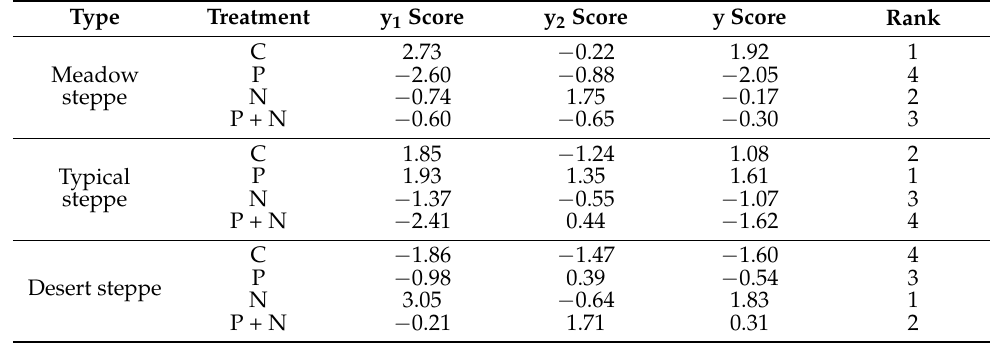
Table 5. Comprehensive scores of soil quality of different grassland types.